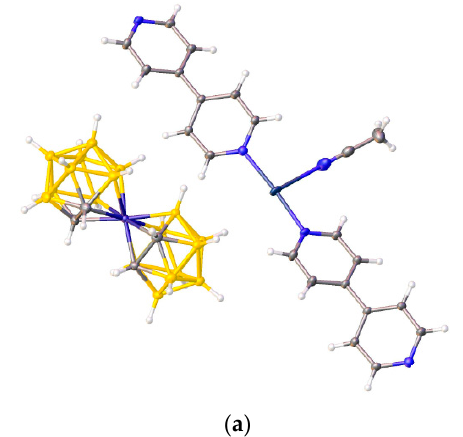
Figure 109. Cont. Figure 109.